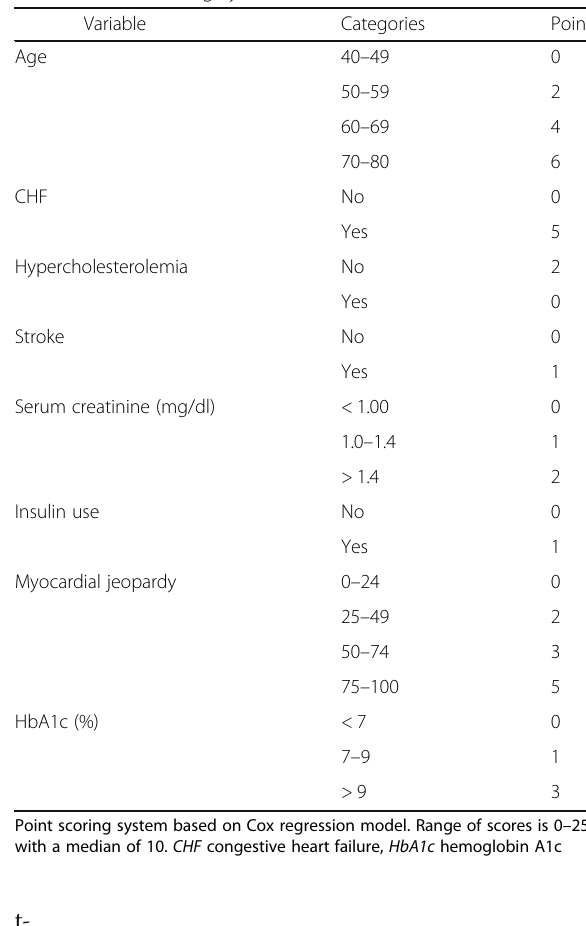
Table 4 Point scoring